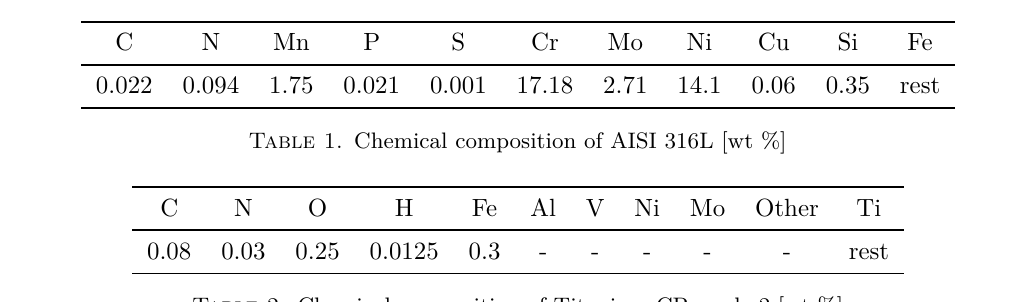
Table 2. Chemical composition of Titanium CP grade 2 [wt %]